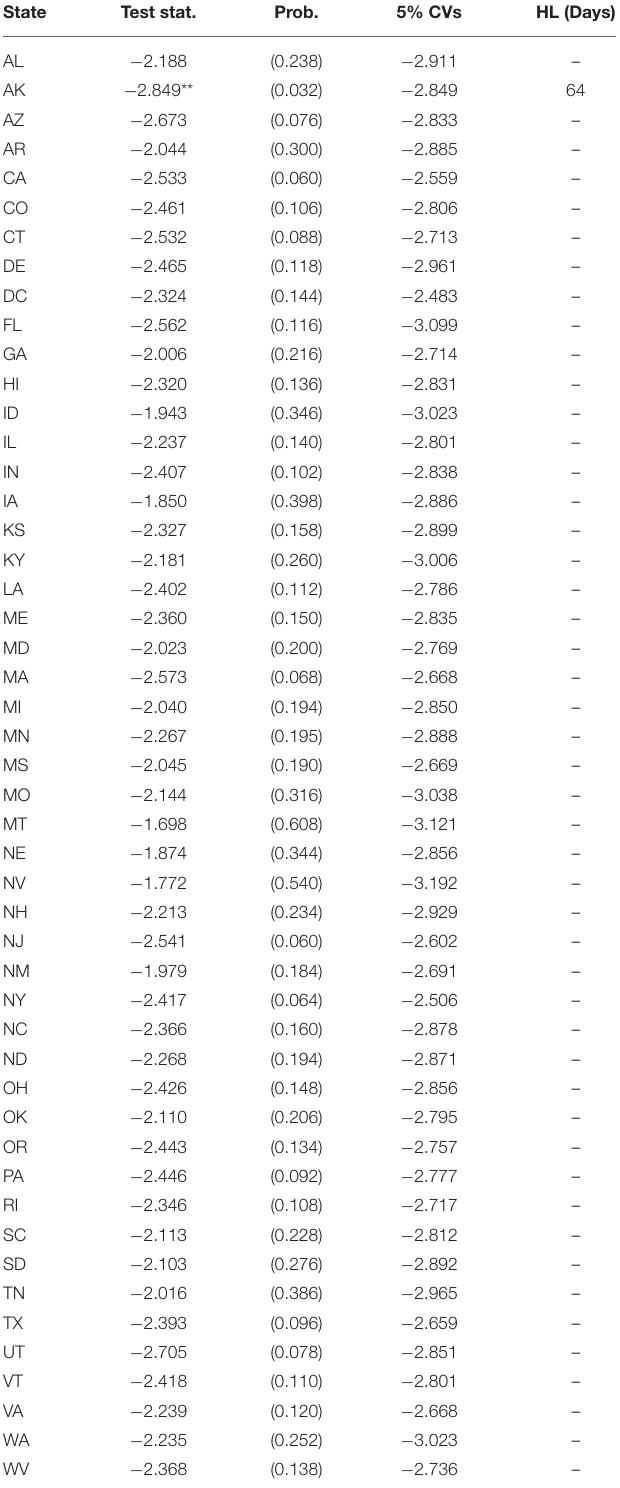
TABLE 2 | Results of the bootstrap unit-root test for a random walk with drift (small businesses revenues, leisure and hospitality). State Test